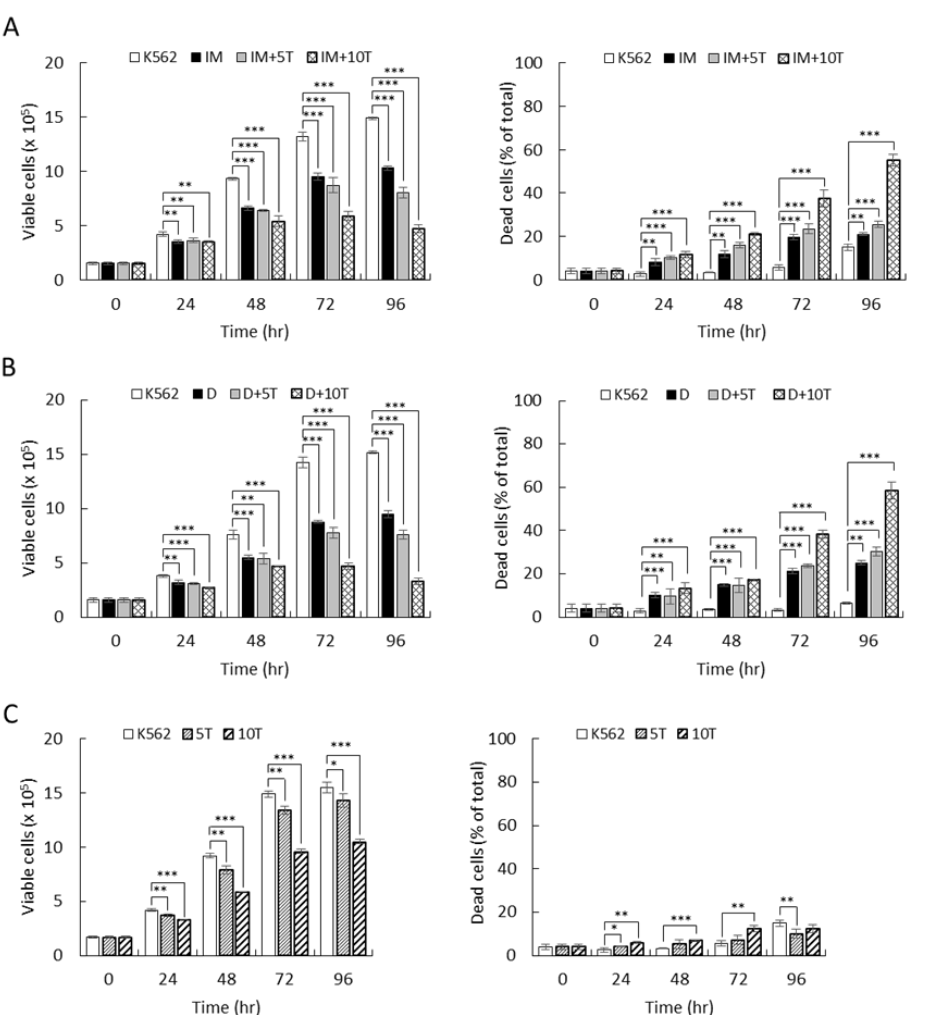
Figure 8. Specific p38 α inhibitor TAK715 greatly increased the therapeutic efficacy of imatinib and dasatinib toward CML cells. K562 leukemia cells were treated with imatinib (0.3 µ M) ( A ) or dasatinib (1 nM) ( B ) in combination with p38 α inhibitor TAK715 (5 or 10 µM). Alternatively, cells were treated with TAK715 (5 or 10 µM) alone ( C ). The viability of cells was examined by trypan blue exclusion. All results shown are representative of three independent experiments. Viable and dead cell numbers are presented as the mean ± SE of three repeats. * p < 0.05, ** p < 0.01, and *** p <